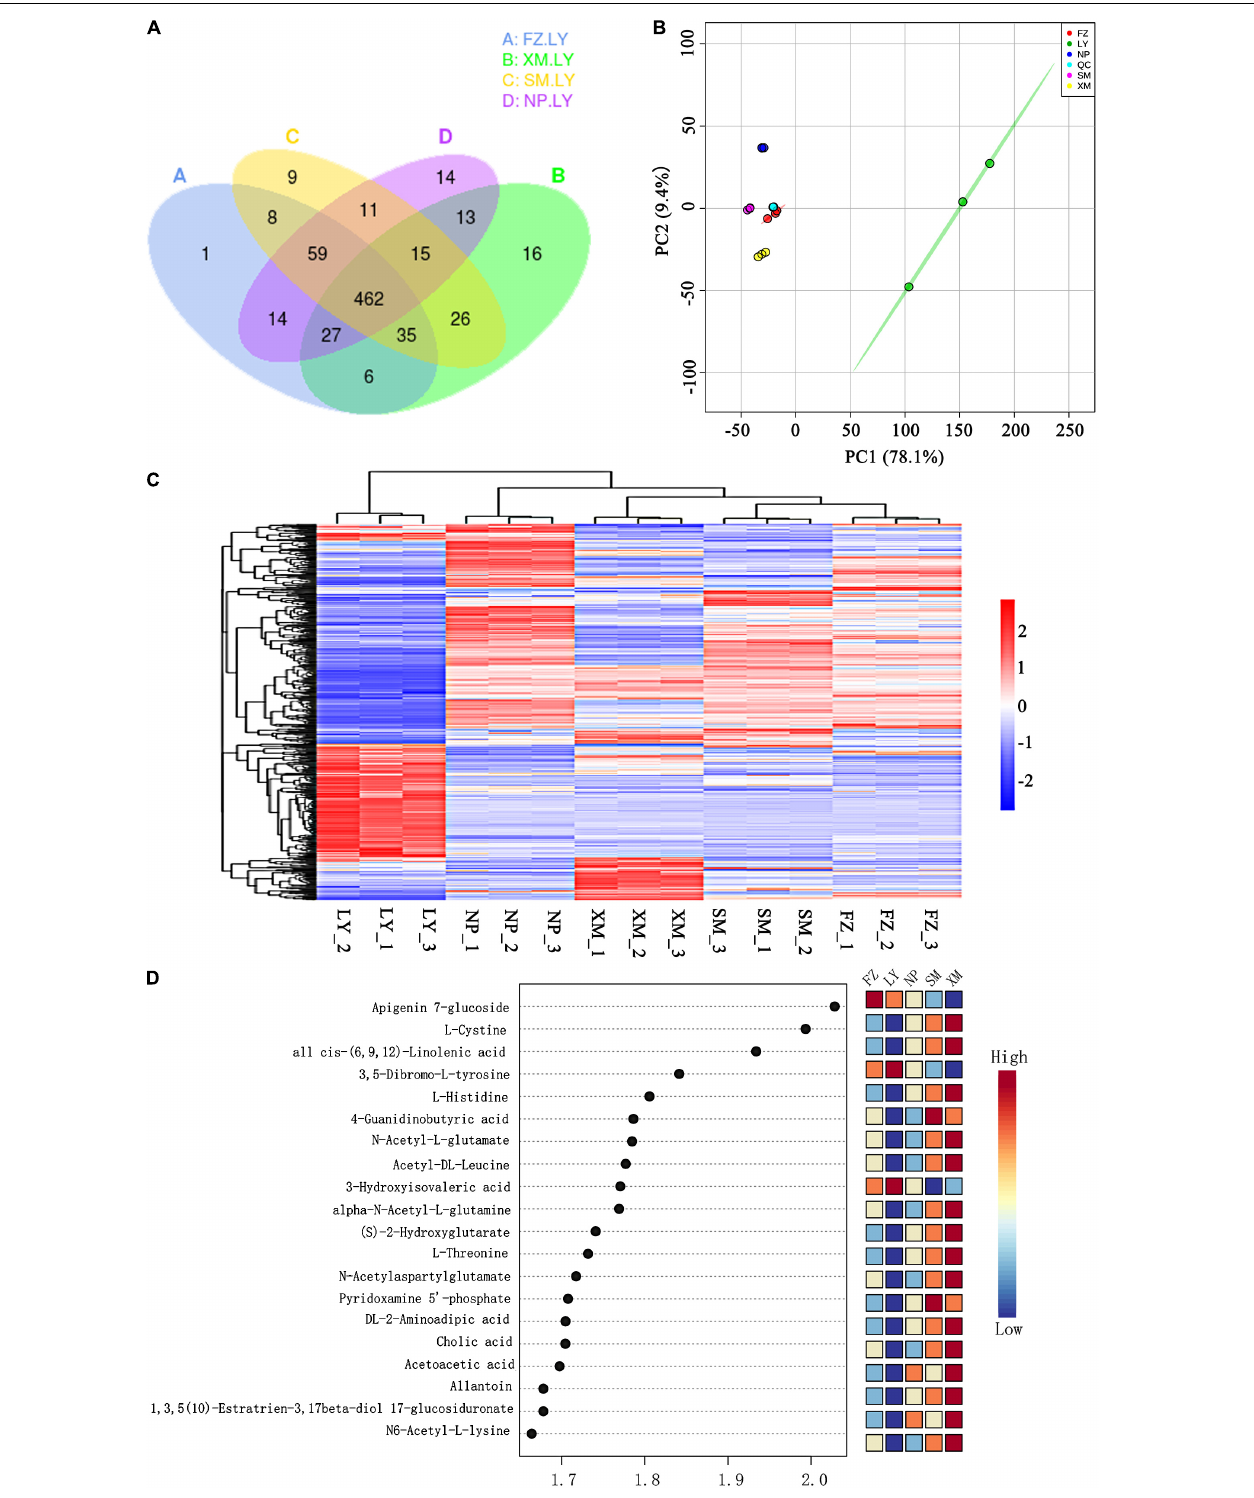
FIGURE 3 | Induced metabolite composition of host plants by different APMSs. (A) Venn diagram of induced metabolites for different AMPSs (SM, FZ, NP, LY, and XM indicate the associated microbes originating from Sanming, Fuzhou, Nanping, Longyan, and Xiamen, respectively) compared with that of LY. (B) PCA of different AMPS samples. Each point in the figure represents a sample, and different colors represent different groups. (C) Hierarchical cluster analysis heat map of all differential metabolites regarding different AMPSs. (D) VIP scatter diagram of different metabolites (showing the top 20 differential metabolites based on VIP value). The abscissa is the VIP value calculated by the OPLS-DA model. The color represents the expression pattern of differential metabolites.